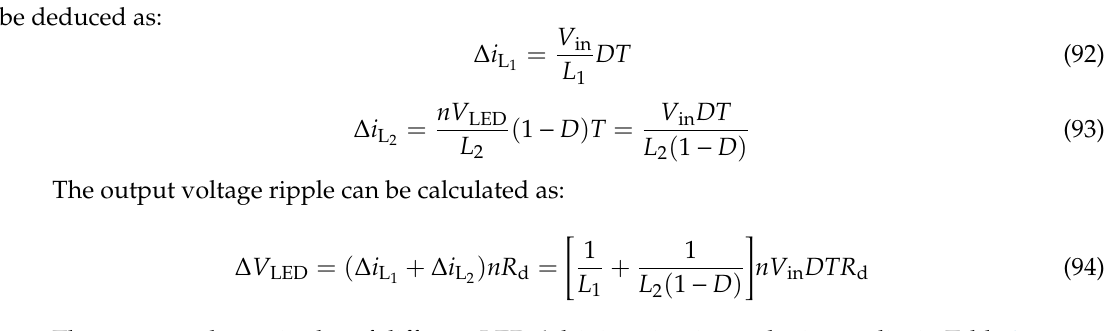
Table 2. Output voltage ripples of different LEDs’ driving circuit topologies.